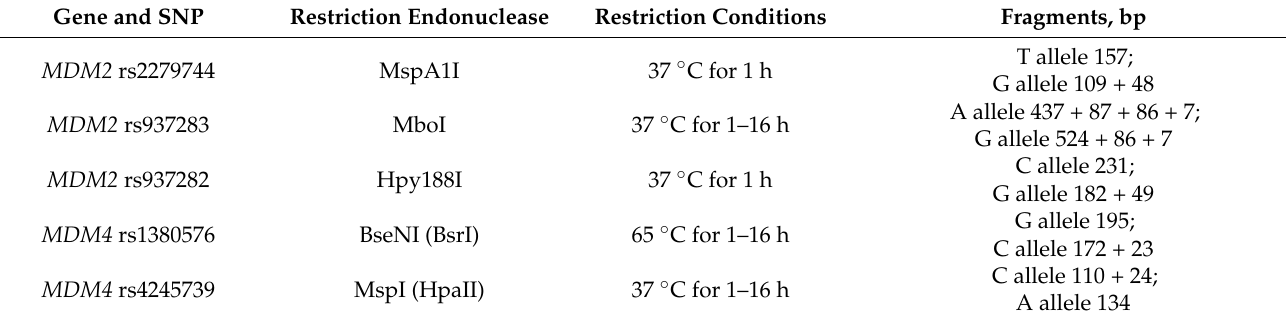
Table 2. The SNP and restriction conditions for